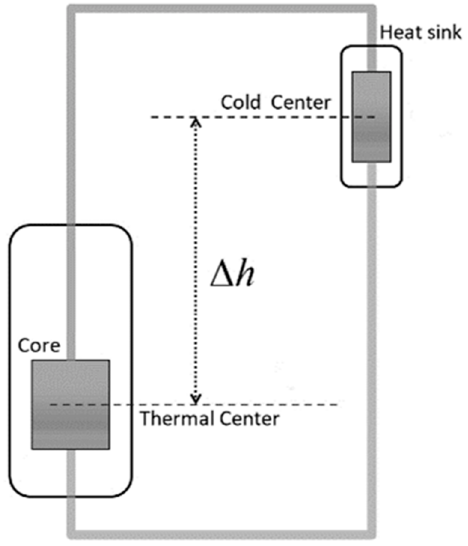
Figure 9. Illustrative diagram of natural circulation in the primary loop.